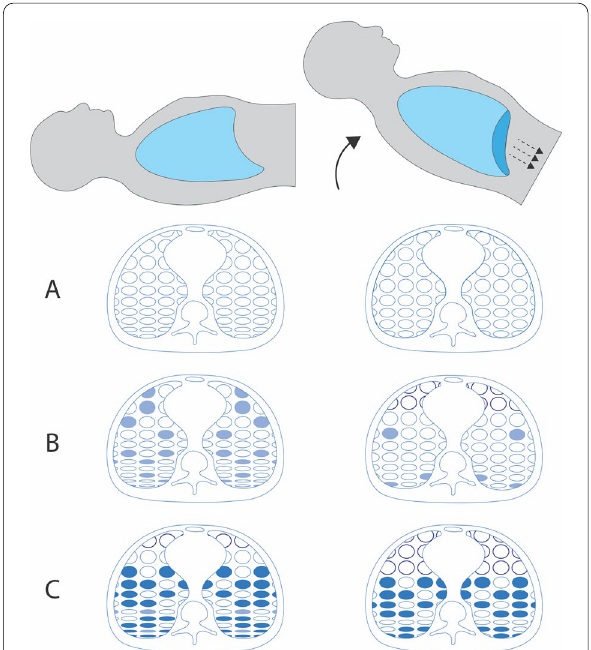
Fig. 2 Effect of upright positioning on end-tidal alveolar distension under passive conditions. The weight of the abdomen is off-loaded with upright positioning, resulting in diaphragmatic descent (dashed arrows), increased transpulmonary pressure ( P L ), and increased lung volumes. In the ‘healthy’ lung ( A ), chest wall compliance ( C CW ) improves, and lung compliance is minimally affected, resulting in improved compliance of the respiratory system ( C RS ). In early ARDS ( B ), increased P L associated with more upright positioning leads to recruitment of lung units that were previously atelectatic (compressed lung units at the bases) or fluid filled (ovals with light shading). While some end-tidal overdistension may occur in non-dependent regions (ovals with thick outline), recruitment exceeds overdistension, resulting in increased C L and C RS . In late-stage, unresolving ARDS ( C ), there is extensive loss of aeratable lung units as edema and atelectasis are replaced by fibrosis and consolidation (ovals with dark shading). Increased PL in more upright positioning then results in minimal recruitment and widespread overdistension; the improved CCW associated with upright positioning is offset by a relatively greater decline in CL, leading to a paradoxical decrease in